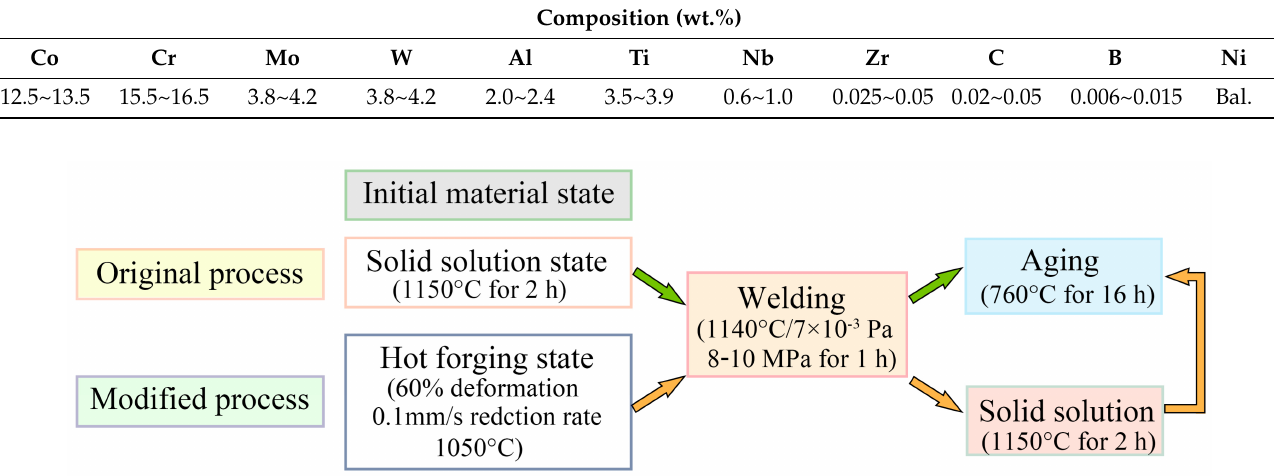
Figure 1. The flowchart for welding processes with two different initial material